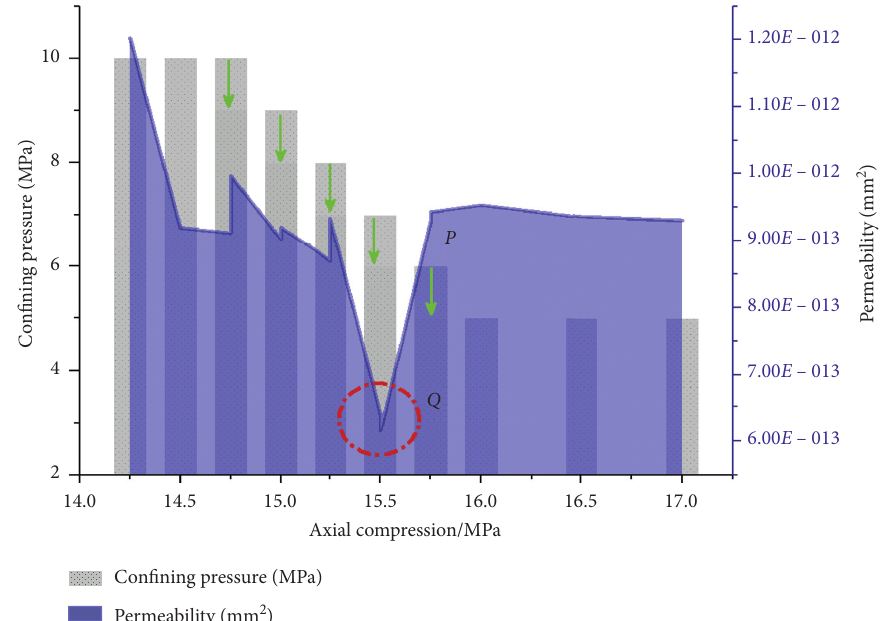
Figure 4: Relationship between permeability and stress state in section of nonactual changing load area in MD-2